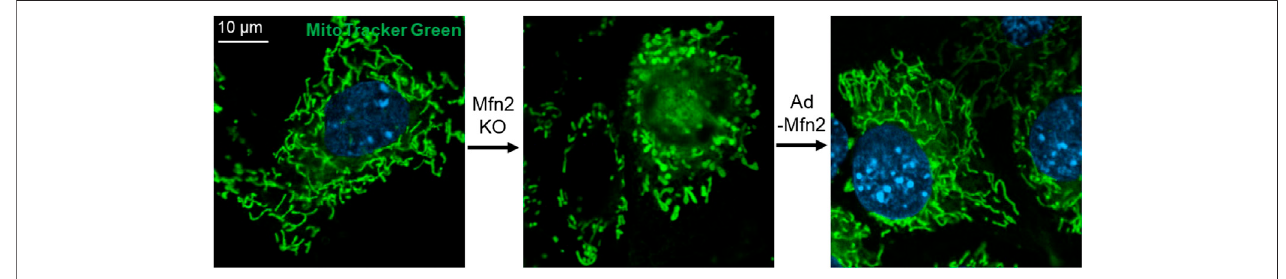
FIGURE 2 | Mfn2 shapes the morphology of mitochondria in MEFs. Mfn2 deletion decreases the fusion activity that leads to mitochondrial fragmentation. The fragmented mitochondria network caused by Mfn2 deletion can be restored by adenovirus-mediated Mfn2 overexpression.